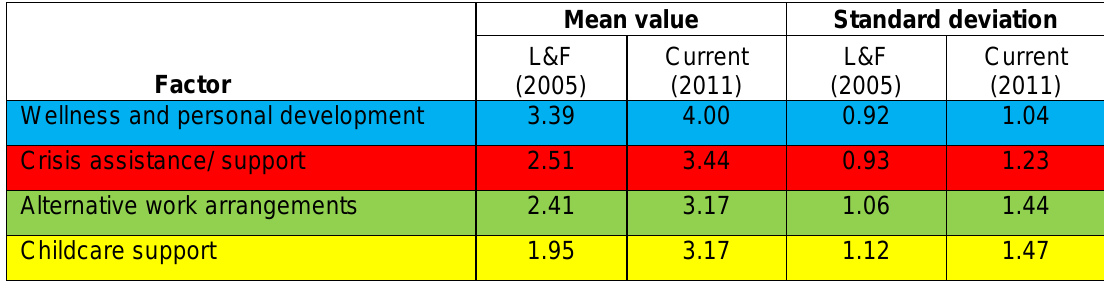
Table 3 Comparison of work-life benefit factor preferences (after Lingard and Francis